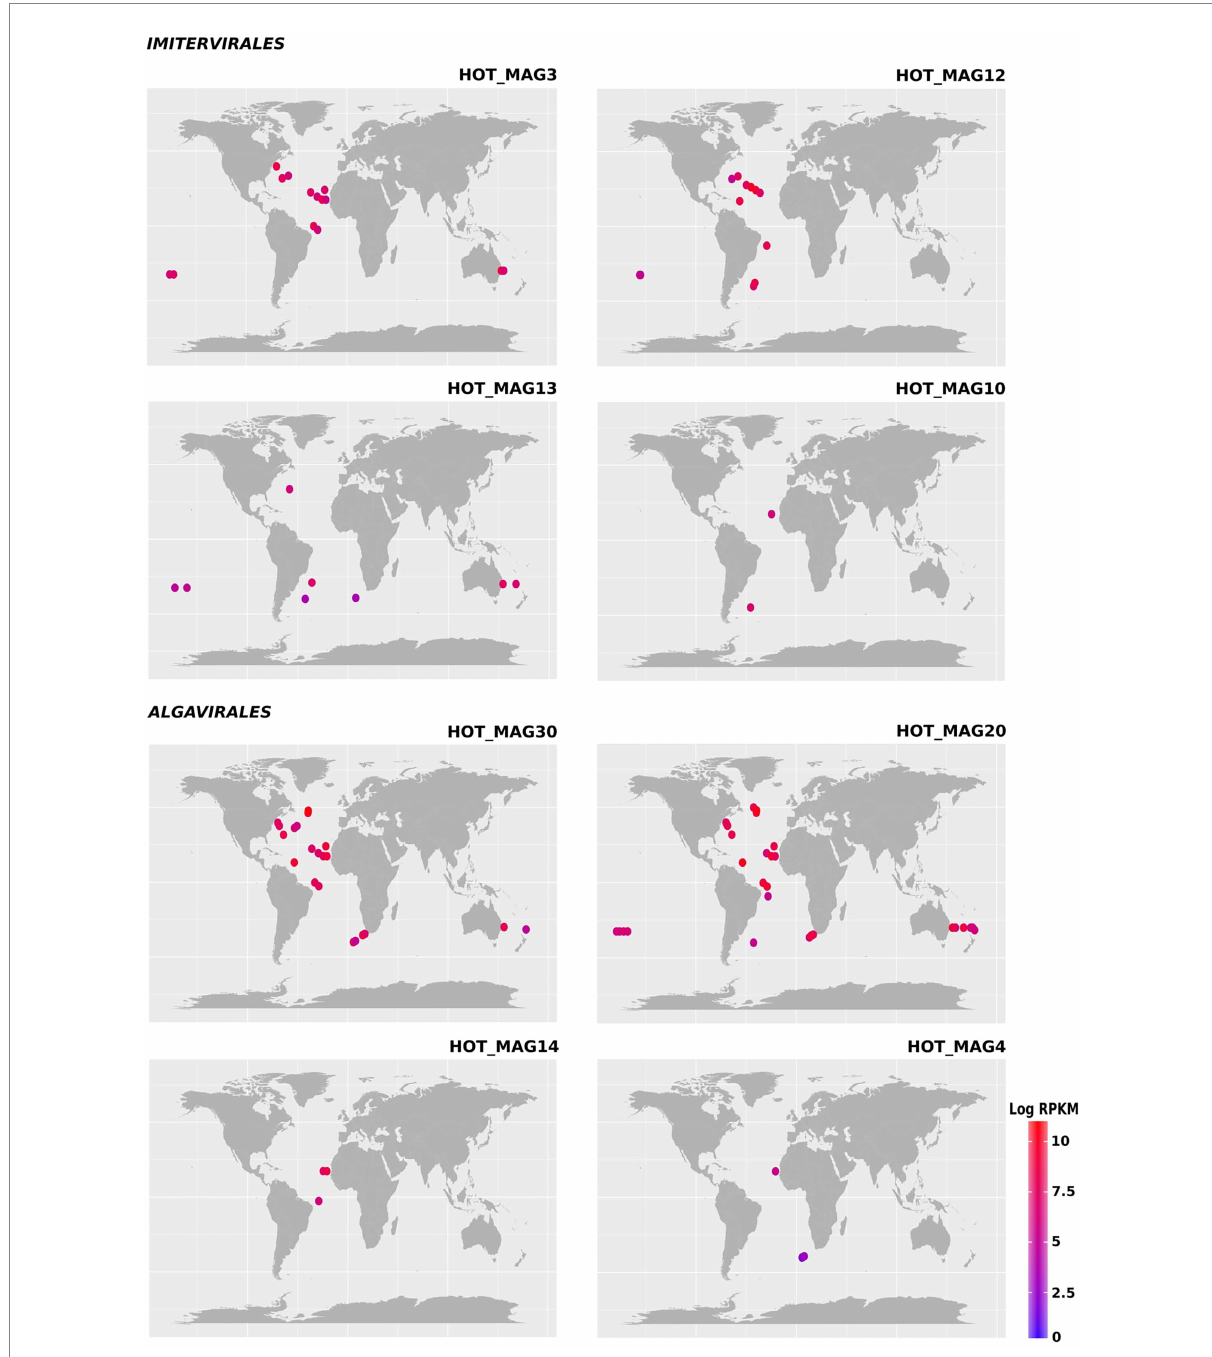
FIGURE 3 Environmental distribution of the HOT MAGs based on read-mapping of bioGEOTRACES metagenomes. HOT_MAGs (22,60) are not shown as they were not identified in bioGEOTRACES metagenomic dataset. HOT_MAG5 is not presented as it is closely related to HOT_MAG3 and its abundance is nearly the same as HOT_MAG3. Bubbles indicate the global distribution of the MAGs which was calculated based on RPKM. Moreover, the abundance of the MAGs in distinct sites with the same latitude and longitude are reported in parenthesis; HOT_MAG3 (15), HOT_ MAG12 (12), HOT_MAG13 (8), HOT_MAG10 (2), HOT_MAG30 (23), HOT_MAG20 (30), HOT_MAG14 (3), and HOT_MAG4